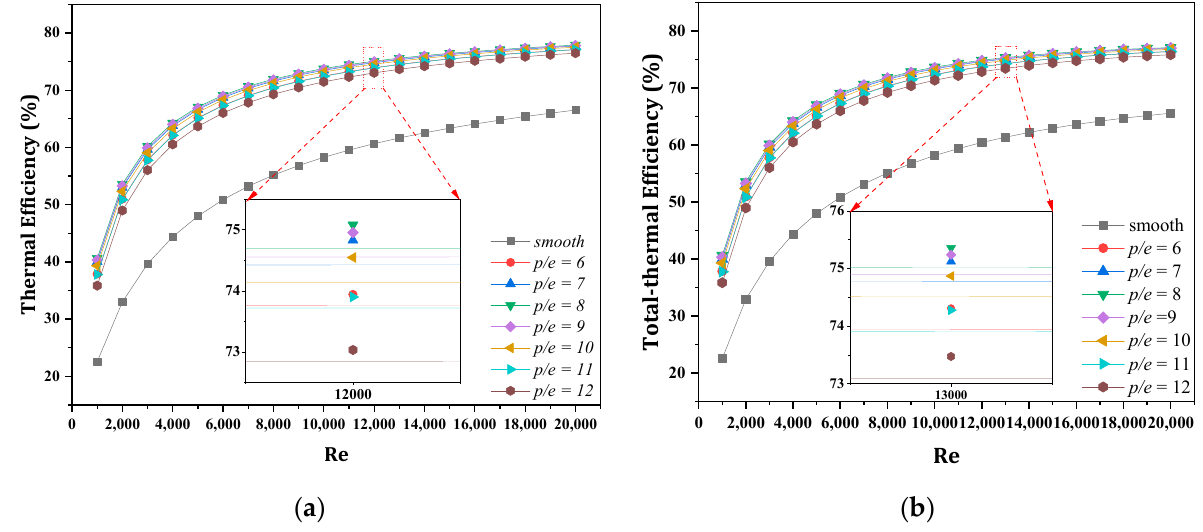
Figure 6. Thermal ( a ) and total thermal ( b ) efficiencies versus Re for smooth and V-down rib roughened surfaces at various pitch ratios 𝑝 𝑒⁄ (in the range 6 – 12 ).